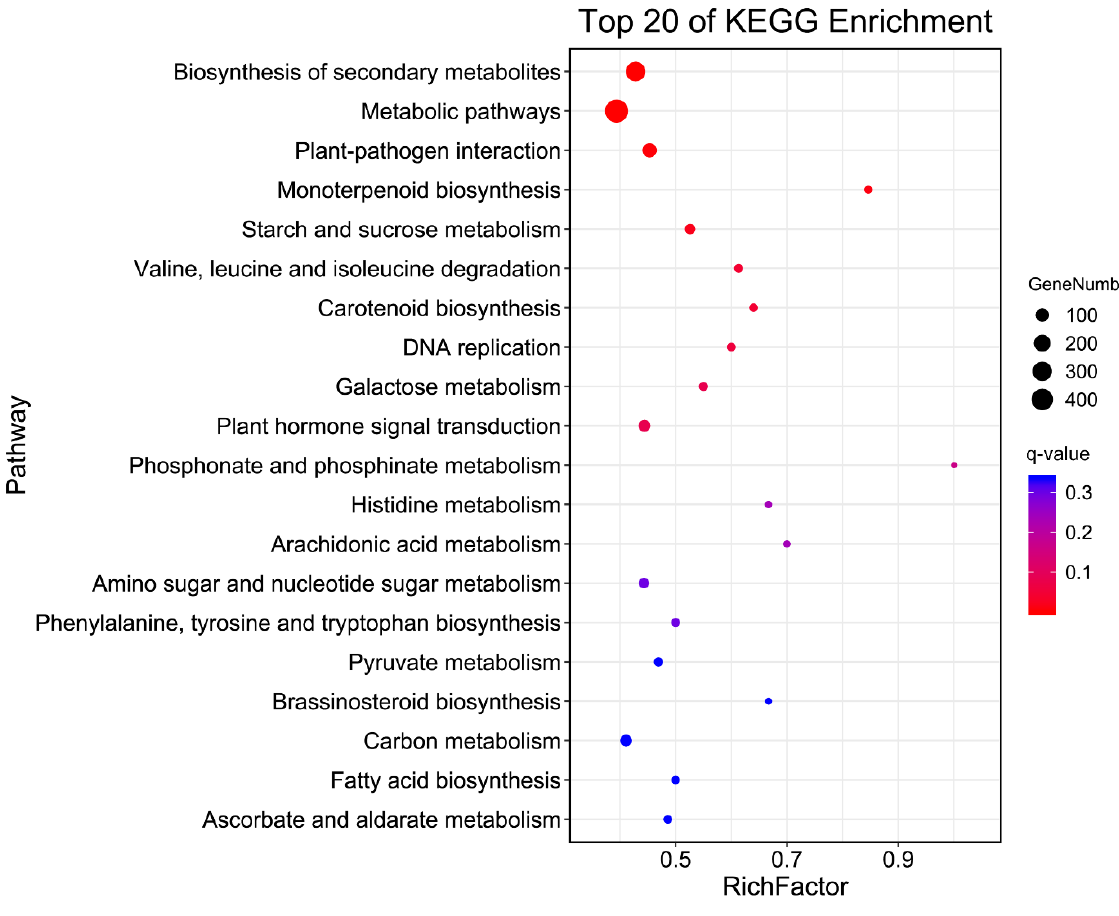
Figure 3. Top KEGG pathways mapping enriched differential progress.